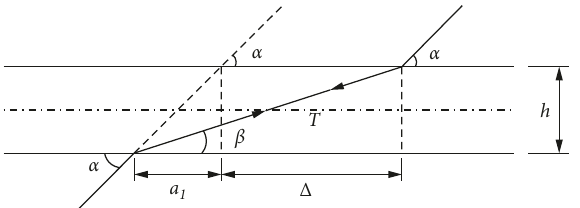
Figure 14: Force model of a single fibre under the shear action of a soil body.